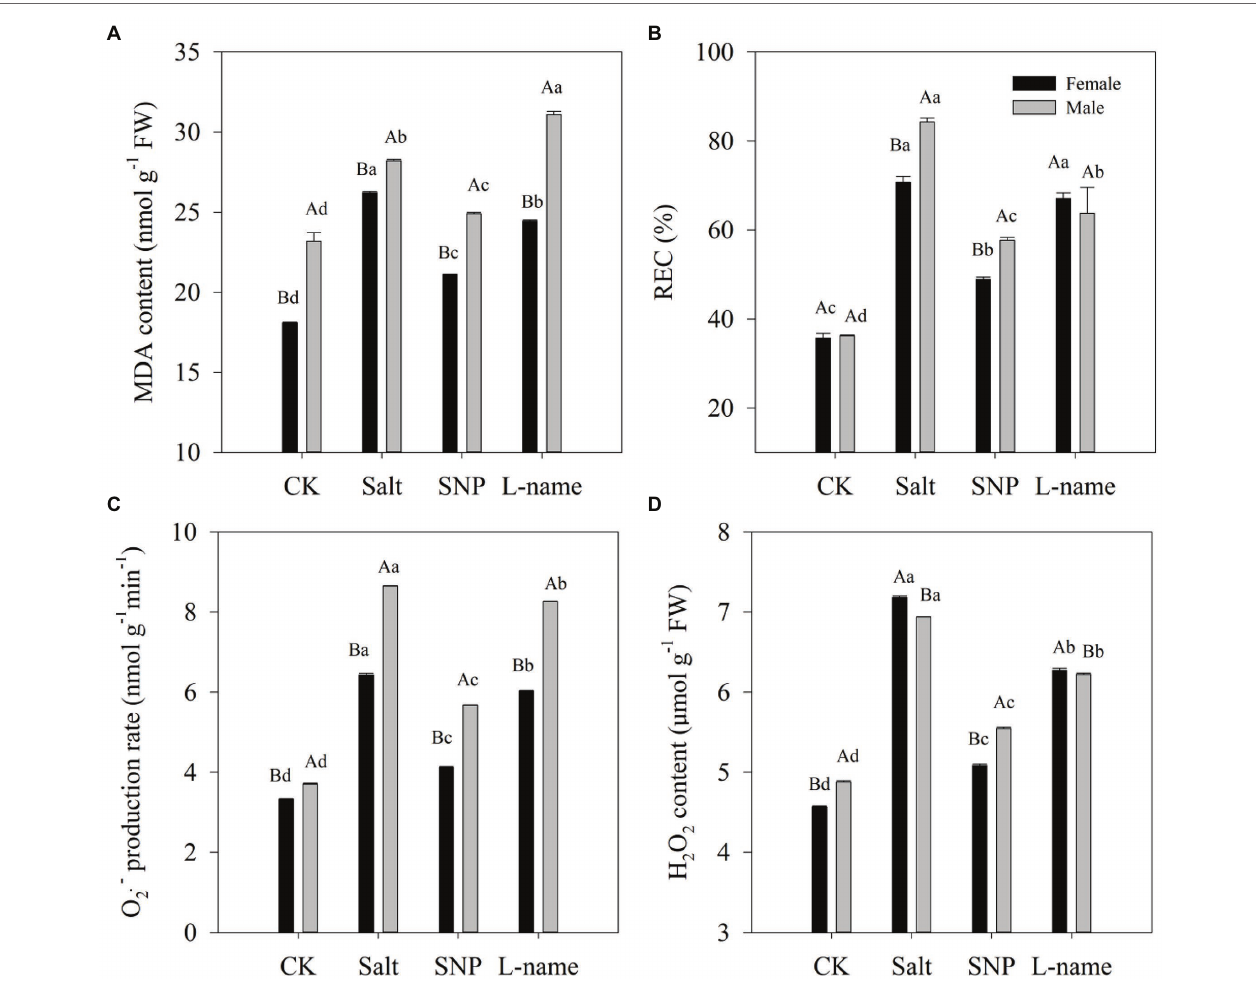
FIGURE 3 | Lipid peroxidation [MDA content (A) , REC (B) , O2·- production rate (C) , H2O2 content (D) ] of T. grandis leaves in response to different treatments. CK (control, distilled water), salt (100 mM NaCl), SNP (100 mM NaCl with 0.05 mM SNP), and L-name (100 mM NaCl with 0.5 mM SNP and L-name). Different uppercase letters indicate a significant difference between different genders at p < 0.05, and different lowercase letters indicate significant difference under salt treatment at p < 0.05, according to Duncan’s